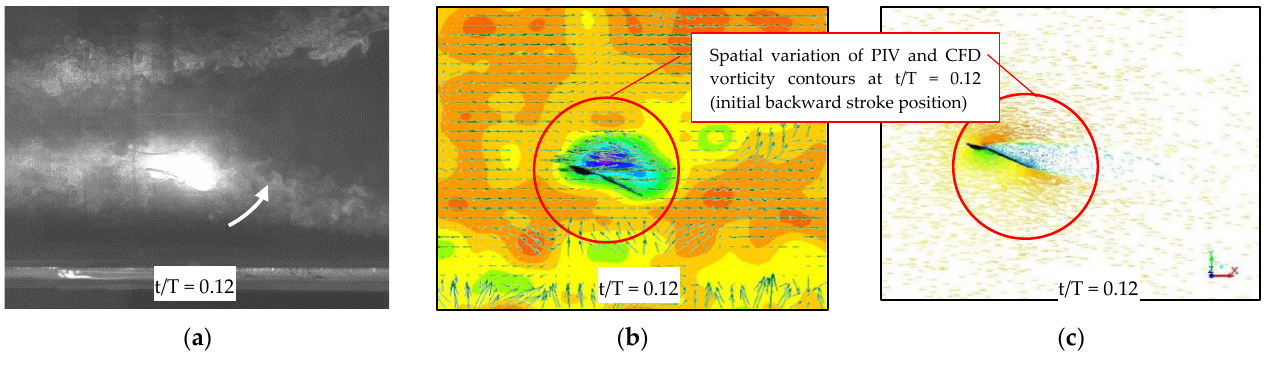
Figure 8. ( a ) Flapping of Kingfisher-inspired wing during experimentation ( z -axis); ( b ) filtered velocity vector field with scalar map at the background, obtained from the 2D-PIV setup at t/T = 0.12; ( c ) CFD velocity vector field at t/T = 0.12.